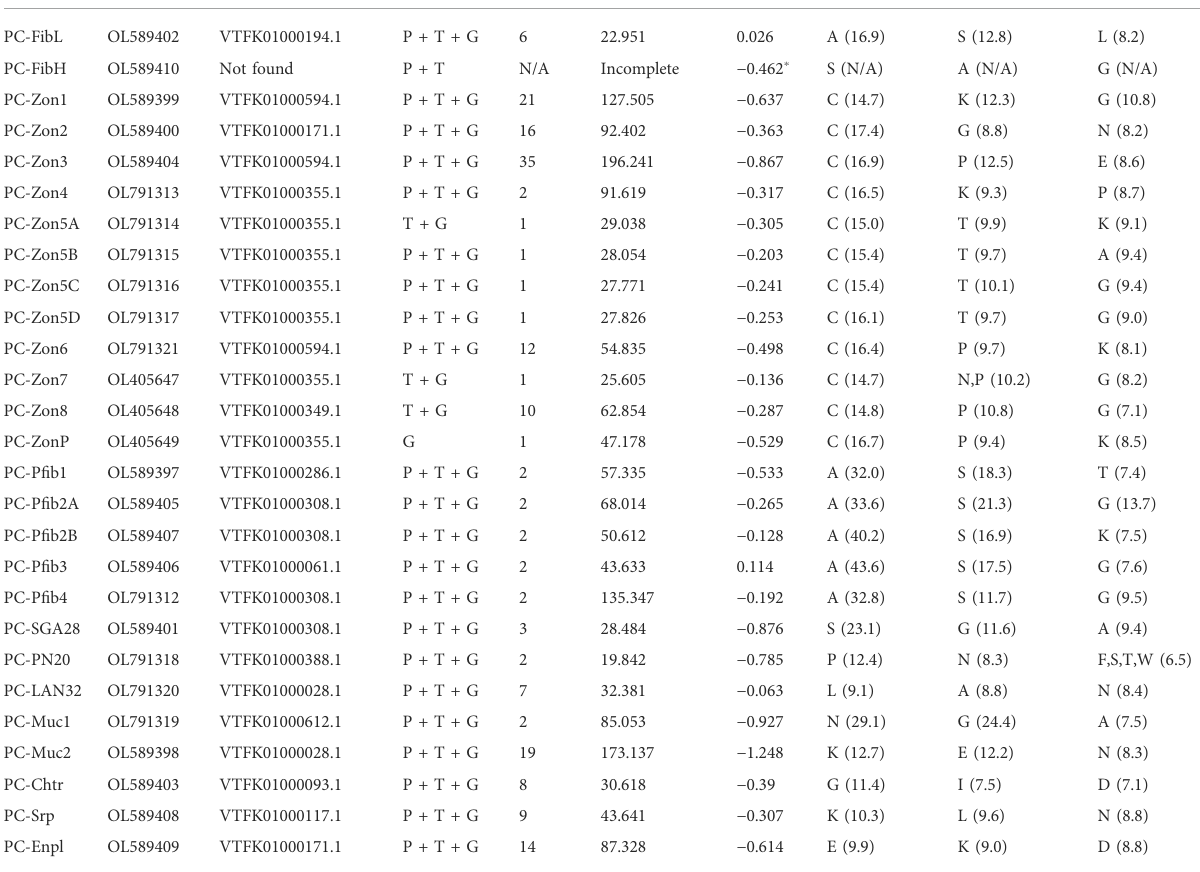
TABLE 2 Candidate silk genes and their